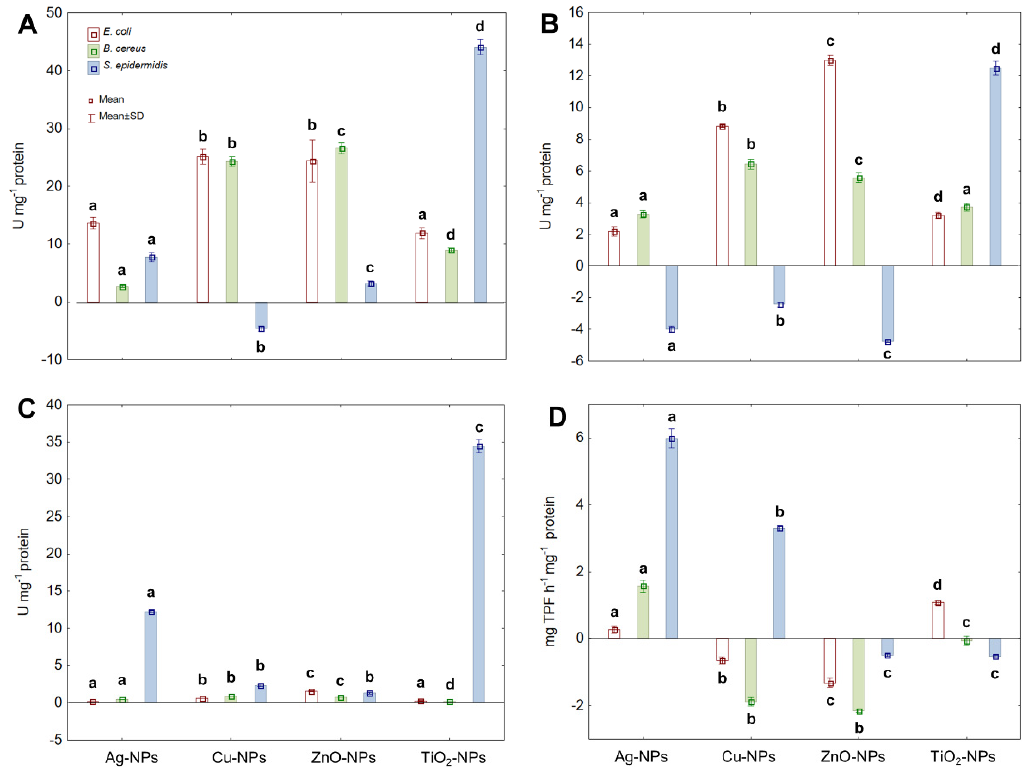
Figure 2. The activity of CAT ( A ), PER ( B ), SOD ( C ) and DEH ( D ) in E. coli , B. cereus and S. epidermidis exposed to NPs at an IC 50 value (mean ± SD; n = 3). Means with the same letter(s) are not significant at p < 0.05 within each enzyme between the control and NPs-treated cells.